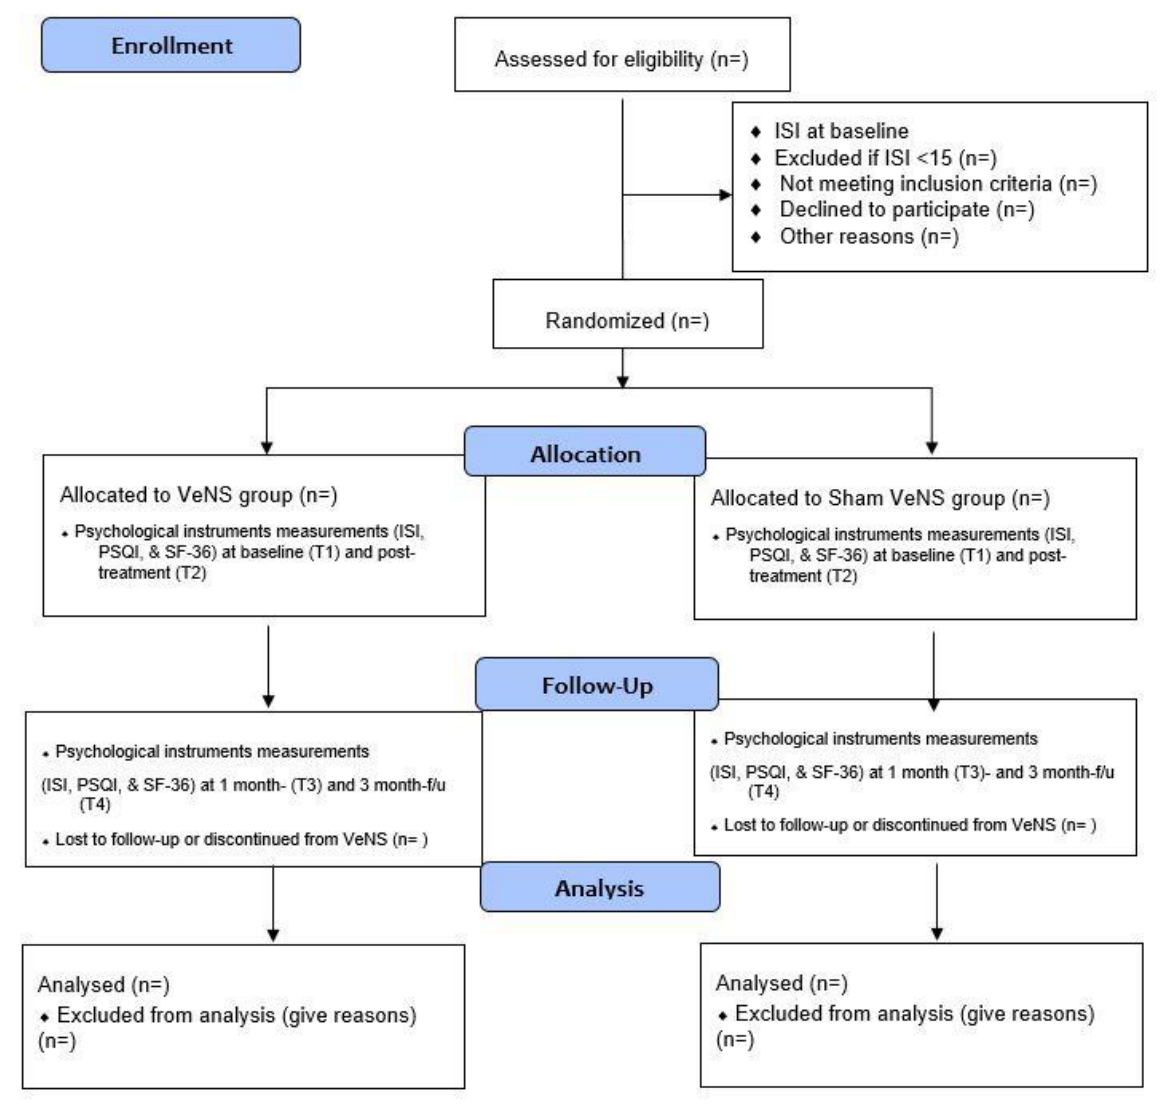
Figure 1. Flow diagram for study design.